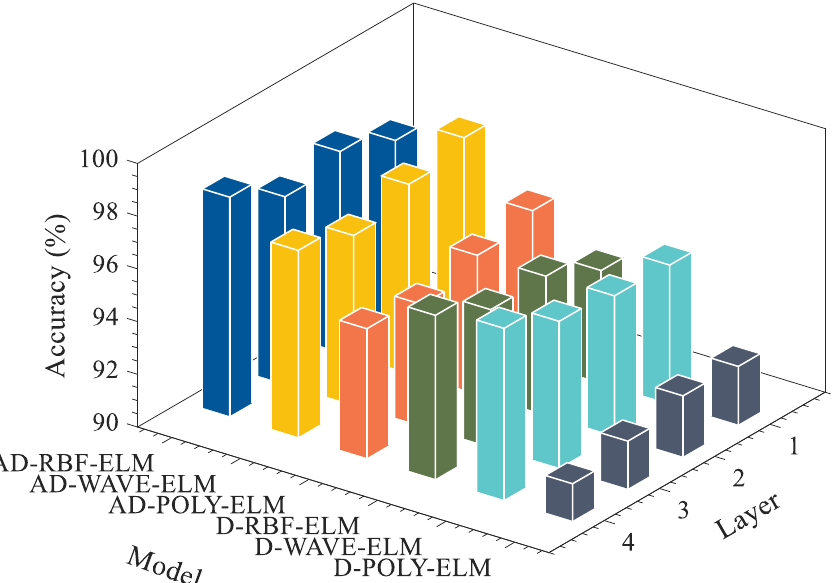
Figure 11. The accuracy rates of different DK-ELM models (University of Cincinnati).